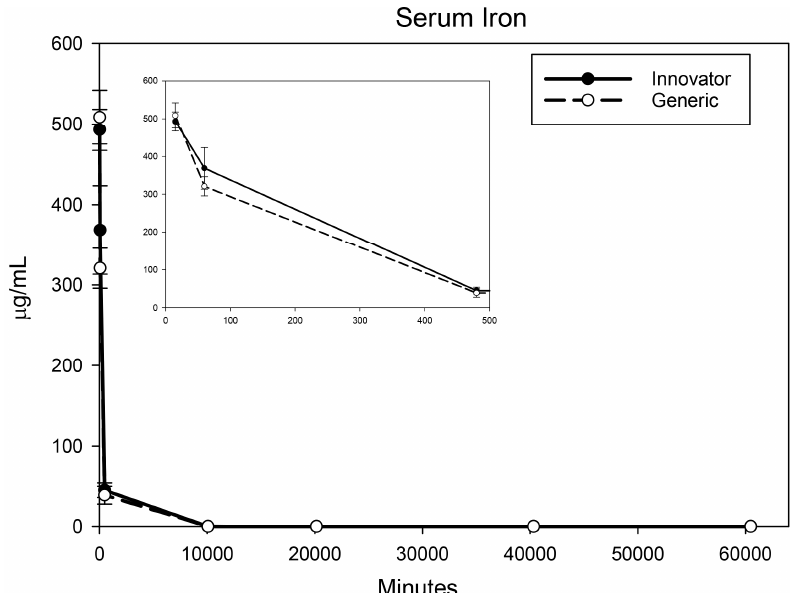
Figure 1. Serum mean iron concentrations over time. Endogenous (control) iron concentration was subtracted from both the innovator (solid) and the generic (dashed). Negative results are not graphed. Time points = 15 min, 60 min (1 h), 480 min (8 h), 10,080 min (1 week), 20,160 min (2 weeks), 40,320 min (4 weeks), 60,480 min (6 weeks). Inset shows the first three time points (15 min, 1 h, 8 h). Values are shown as mean + SD; n = 6 per group per time point.